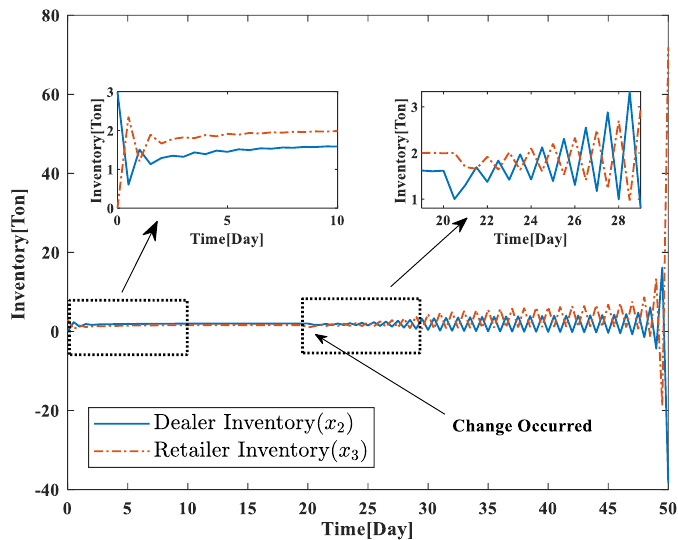
Figure 11. Supply chain system inventory status without optimization